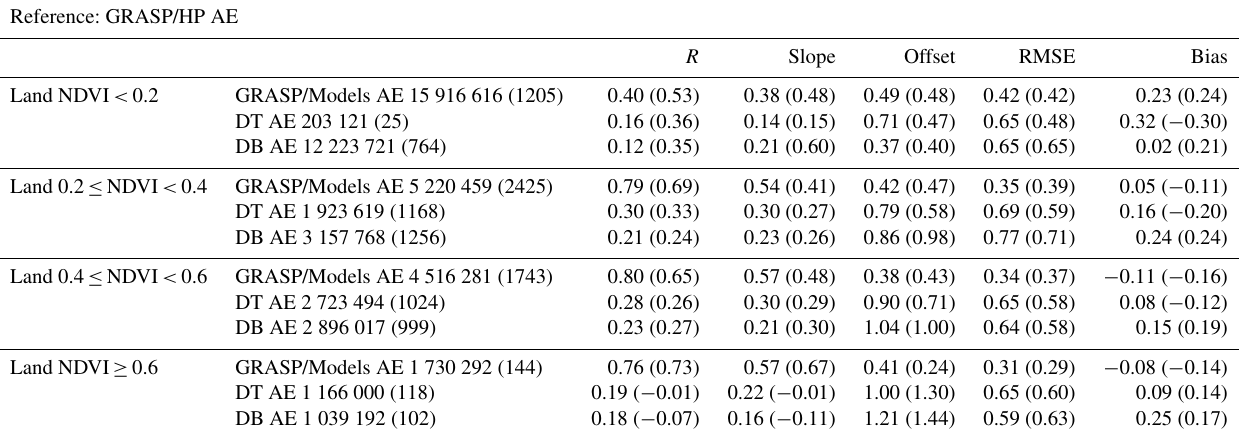
R Slope Offset Bias